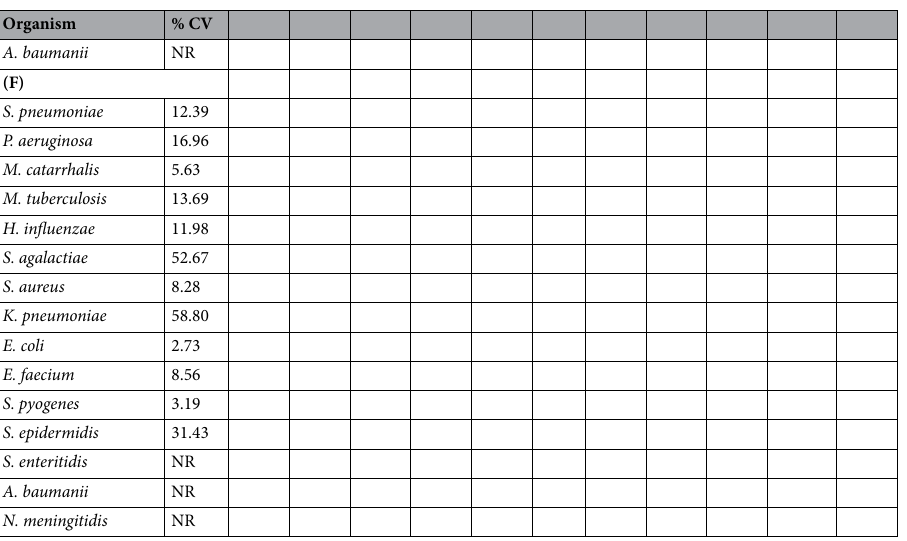
Table 5. The precision of MCM2α reported as percentage coefficient of variation (%CV) from triplicate technical repeats of each of the family of organisms reported by the 13 different laboratories for the 16S